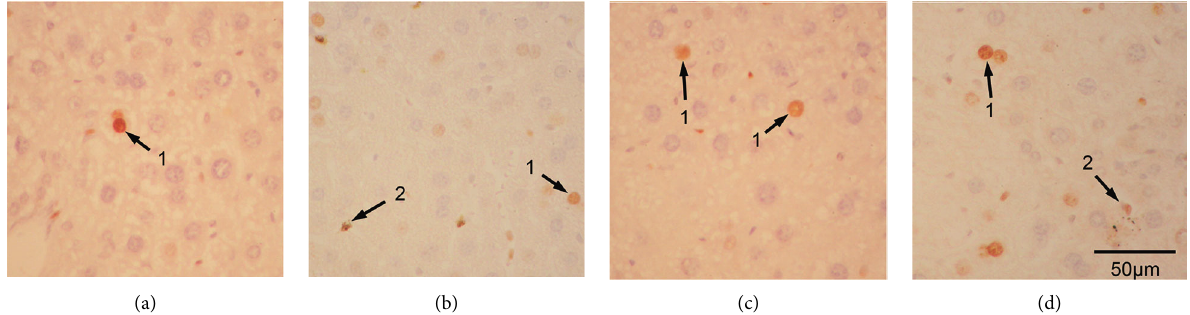
Figure 7: MCM2-positive nuclei in the saline- (a), ethanol- (b), fluoxetine- (c), and atorvastatin-treated (d) liver. Arrows denote positive cells; 1 denotes a positive liver cell nucleus; and 2 denotes a Kupffer or a stellate cell nucleus,